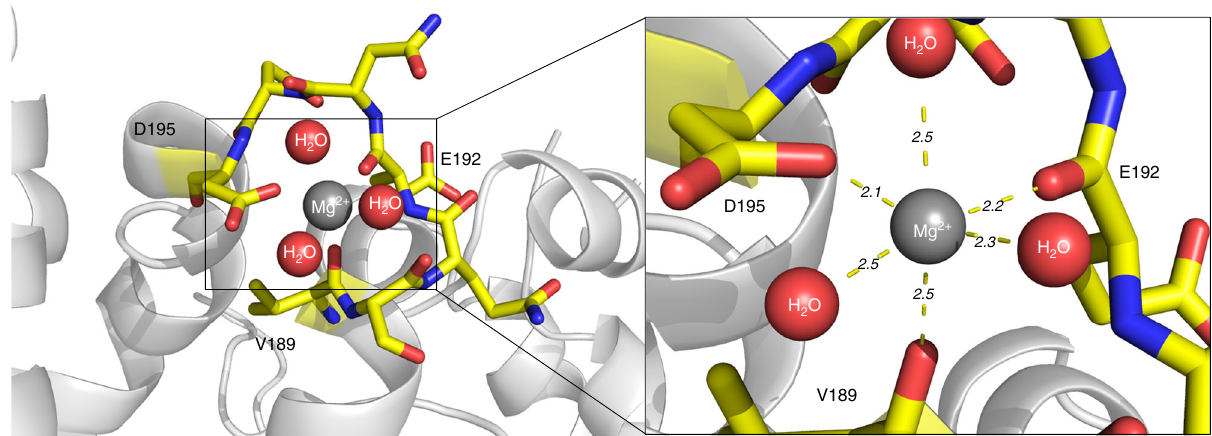
Fig. 4 Coordination sphere of the magnesium ion. The residues of the loop carrying the Mg 2+ binding site are represented as sticks. The Mg 2+ ion is coordinated by the main chain carboxyl groups of V189 and E192, and the side chain carboxyl group of D195. The octahedral coordination sphere is completed by three water molecules. The right panel shows a close-up view of the binding site, indicating the distances to the coordinating atoms (Fig. 5b) and altered the folding of the proteins as measured by dynamic light scattering. These data suggest that toxicity is mediated at least in part through nigritoxin ’ s C-terminal domain, as does the fact that no toxicity was induced by constructs lacking this domain. However, the C-terminal domain was not suf fi cient to induce Sf9 cell death (Fig. 5a). Immuno fl uorescence assays suggest that this may re fl ect a role for nigritoxin ’ s N-terminal domain in toxin internalization, as only polypeptides that included the N-terminal domain showed marked intracellular accumulation (Fig. 5b). The truncated forms of nigritoxin were similarly detected by sodium dodecyl sulfate (SDS) – polyacrylamide gel electrophoresis (PAGE) and Western blot with polyclonal anti-nigritoxin antibodies, showing that these results were not due to protein instability or lack of detection by the antibodies (Supplementary Fig. 13). Thus, our working hypothesis is that the toxin ’ s structural domains have distinct roles: the N-terminal domain mediates toxin internalization by target cells, while the C-terminal domain is necessary to induce cell death through apoptosis.